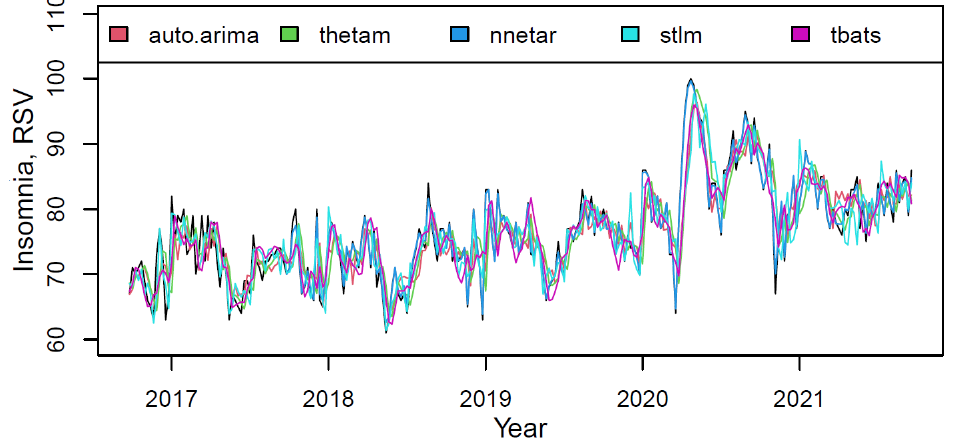
Figure 3. The actual (black) and fitted values of each component of the M3 hybrid model.